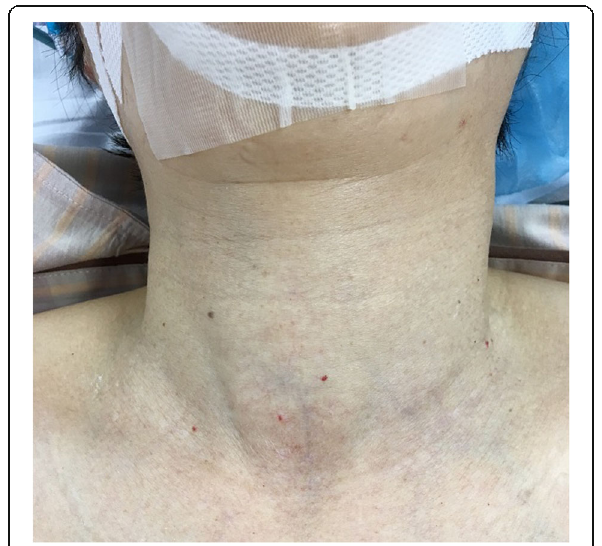
Fig. 1 Image shows slight left neck enlargement